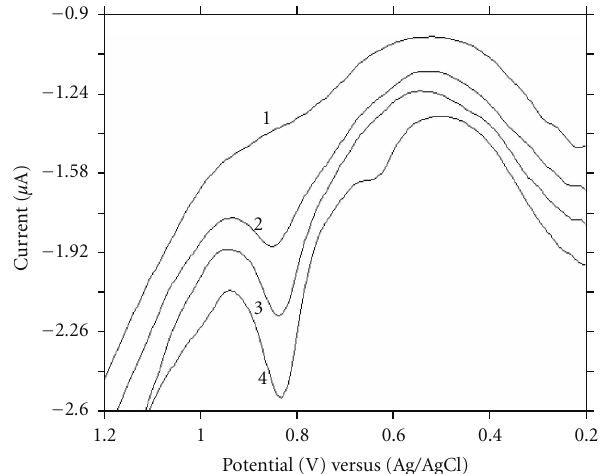
Figure 4: DP voltammograms in 0.1 M sulphuric acid for the determination of fulvestrant in spiked human serum samples: (1) blank serum extract, (2) extract containing 4 × 10 − 5 M, (3) extract containing 6 × 10 − 5 M, and (4) extract containing 1 × 10 − 4